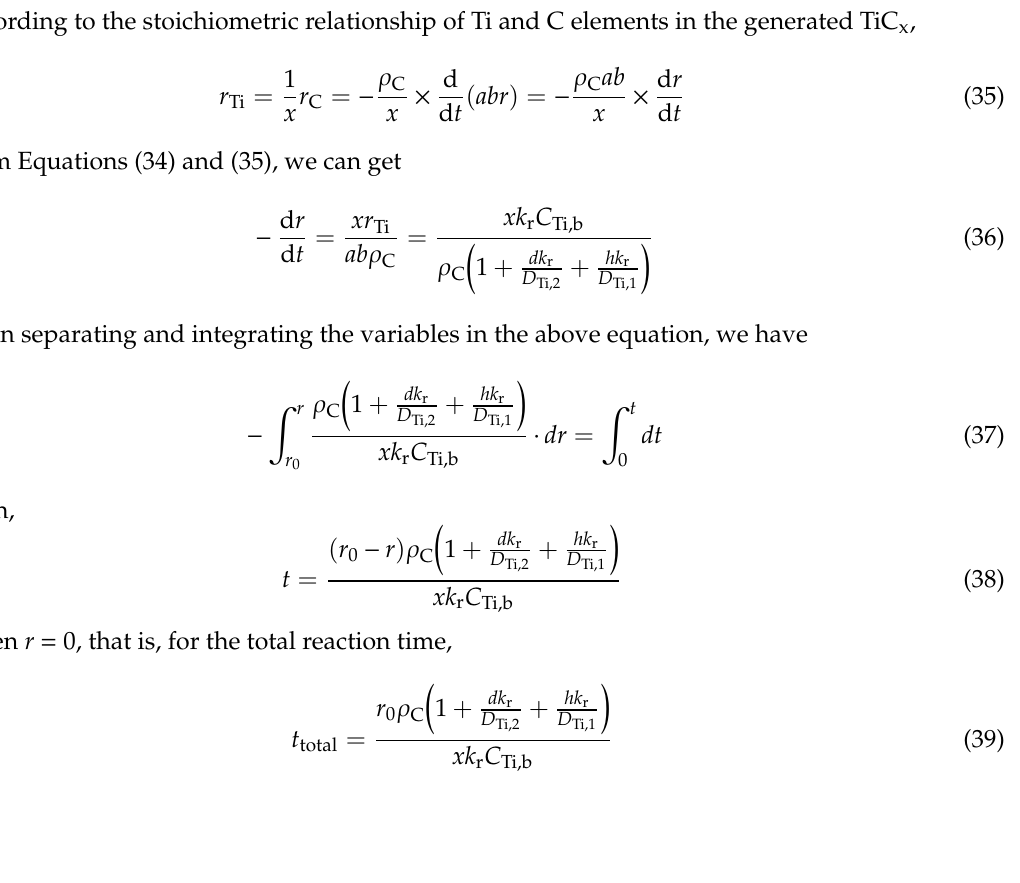
Figure 3. The schematic diagram of reaction mechanism of flat solid C source particles in Cu-Ti melt.